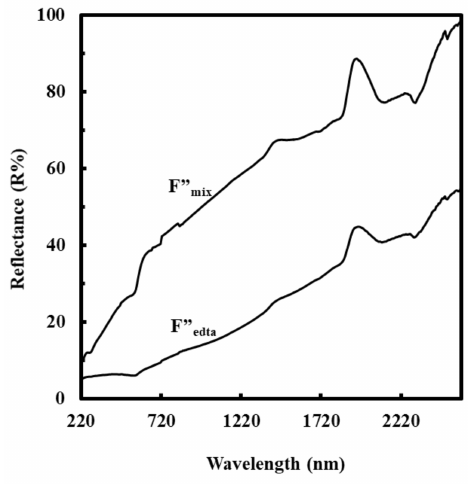
Figure 4. Reflectance spectra of F” edta and F” mix .